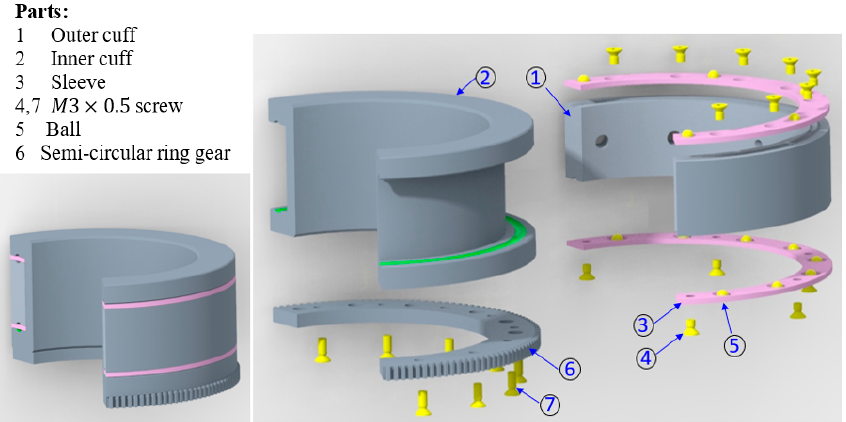
Figure 9. Elbow and forearm motion support part.